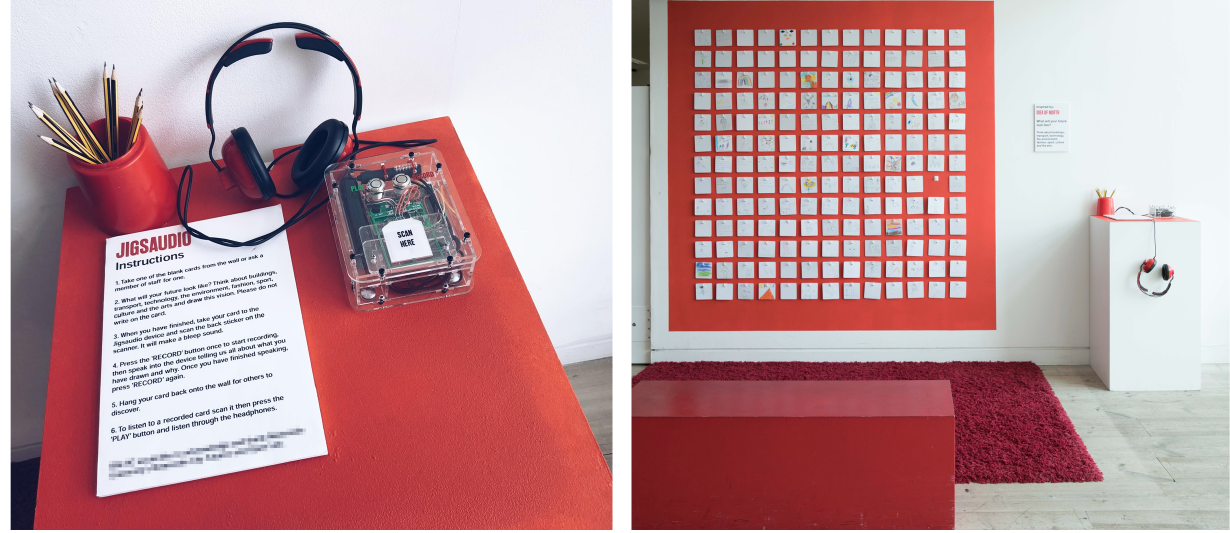
Figure 1. An example of one deployment at a modern art gallery in Gateshead, UK: JigsAudio device (left) and the public visual artefact—a tile mural of individual contributions